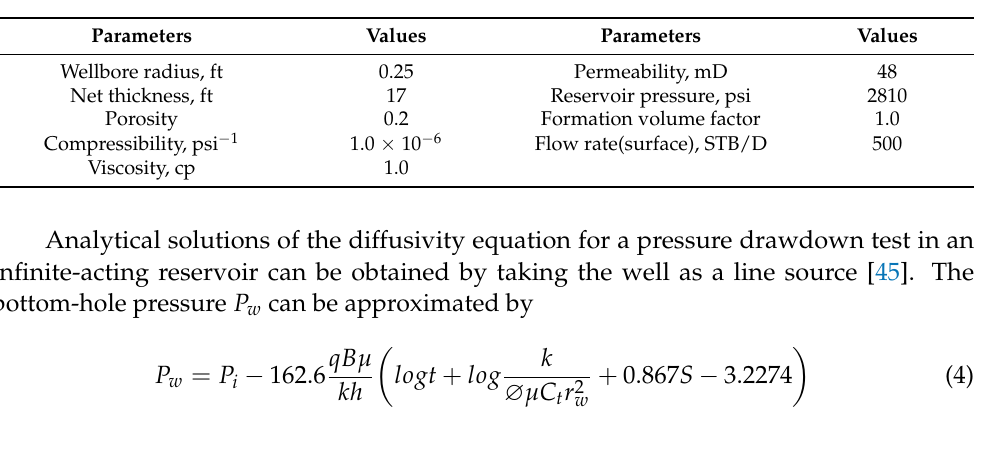
Table 1. Well and reservoir